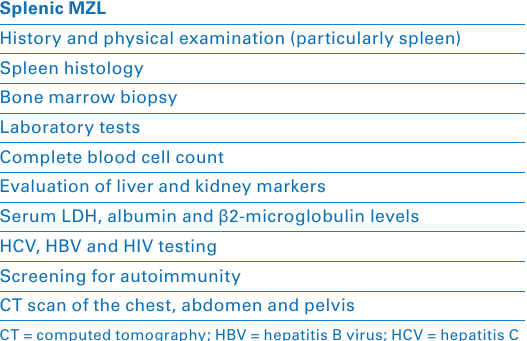
Table 4: Summary of work-up procedures for splenic marginal zone B-cell lymphoma (MZL) [72]. Splenic MZL